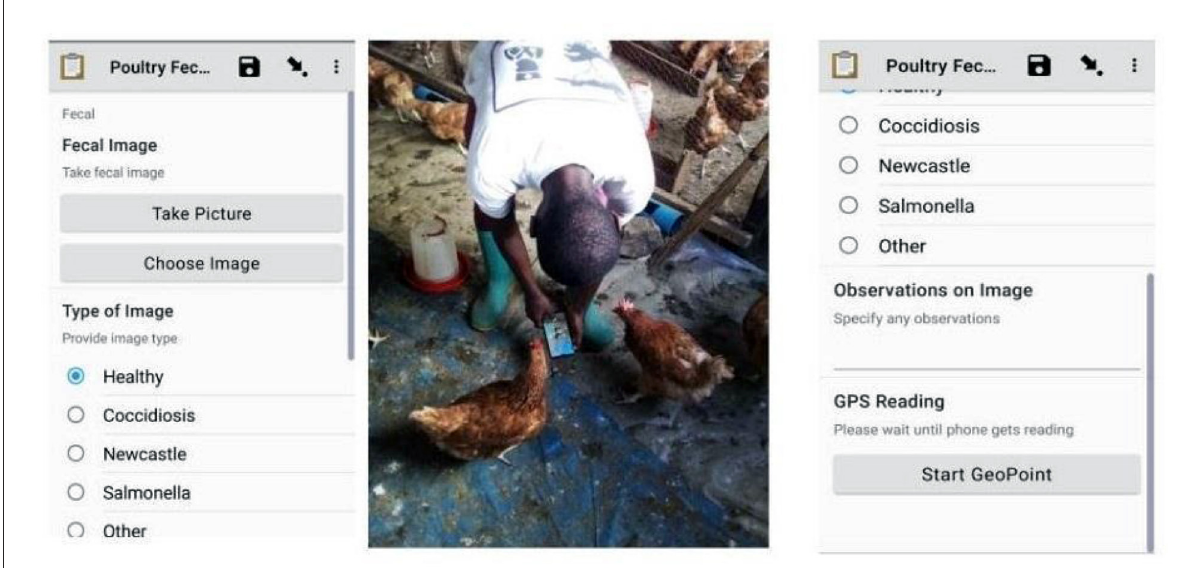
FIGURE1 Veterinarians and researchers administering poultry data collection using ODK.